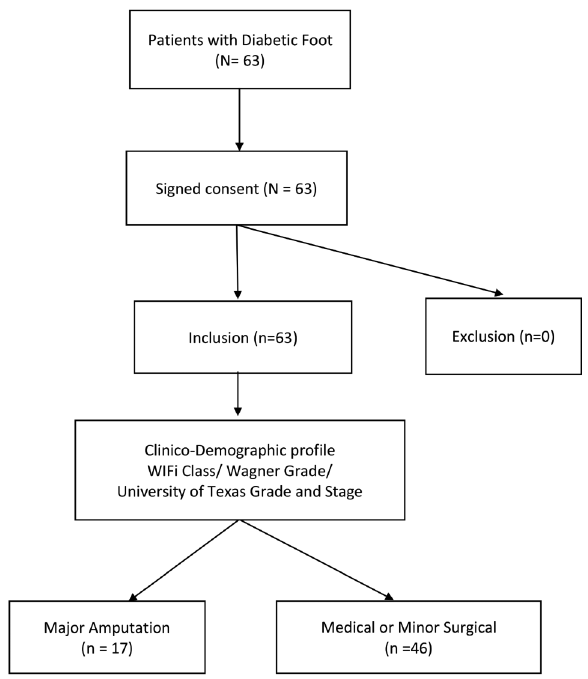
Flowchart for the Conduct of the study. Fig. 2: